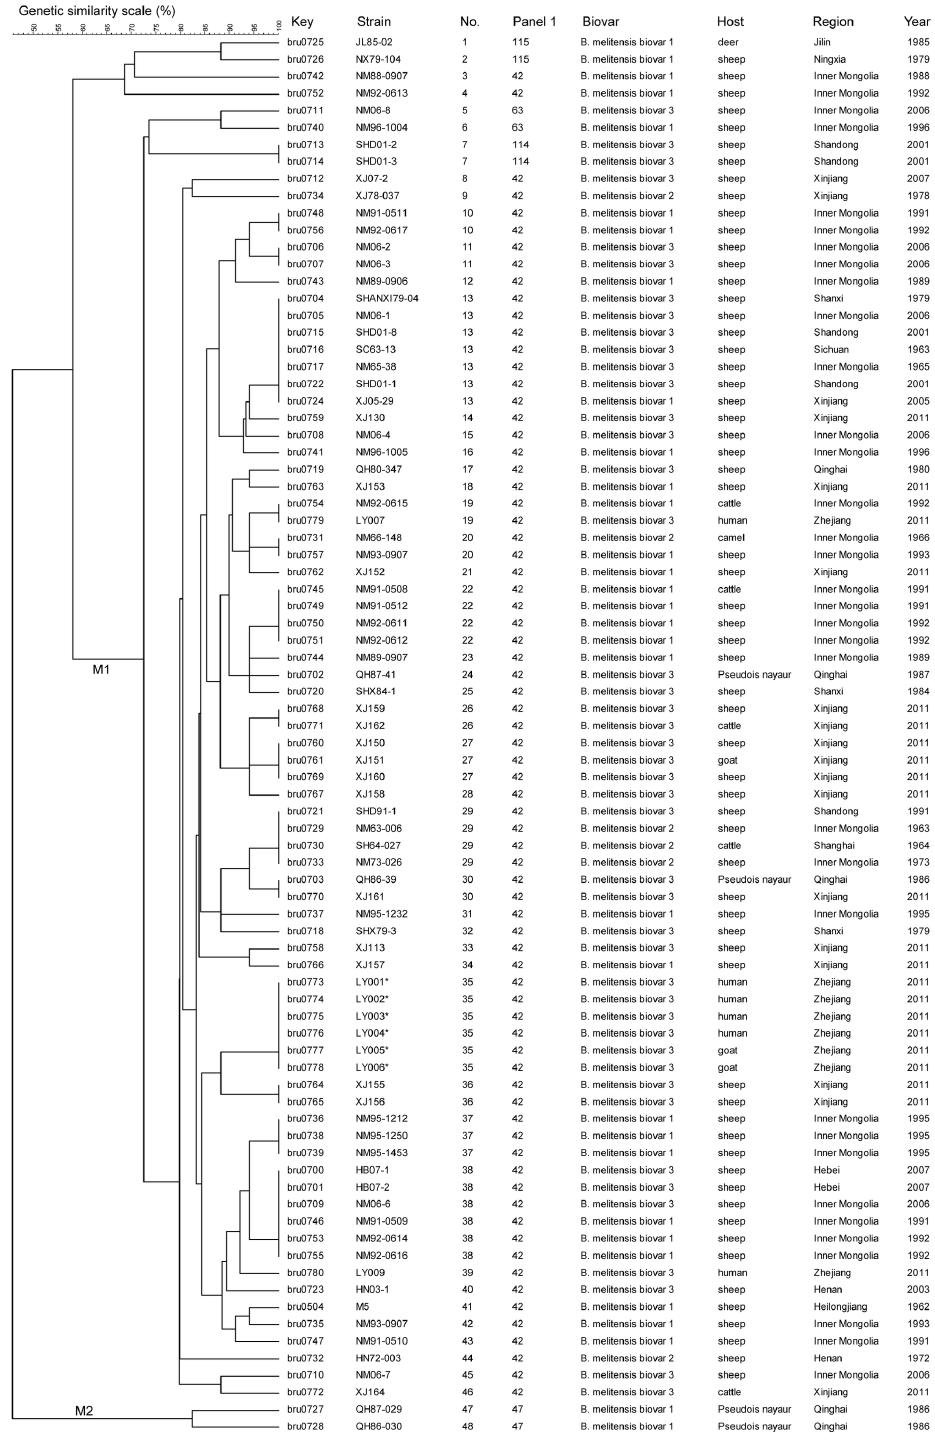
Figure 1. Dendrogram based on the MLVA-16 genotyping assay showing relationships of the 82 B. melitensis strains in this study. In the columns, the following data for isolates are indicated: Key: serial number for the isolate in the Brucella2012MLVA database (Key), strain name in the laboratory (strain), genotype numbering (No.), Panel1 genotypes corresponding to each isolate in the Brucella2012, geographic region (Region), year of isolation(Year). Outbreak isolates recovered from Longyou country are marked with an asterisk. doi: 10.1371/journal.pone.0076332.g001 PLOS ONE |